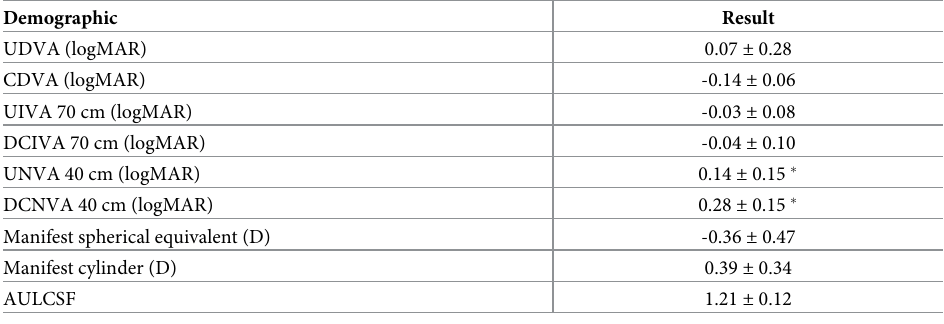
UDVA = uncorrected distance visual acuity; CDVA = corrected distance visual acuity; UIVA = uncorrected intermediate visual acuity; DCIVA = distance- corrected intermediate visual acuity; AULCSF = area under the log contrast sensitivity function. � Analysis data of 21 eyes.